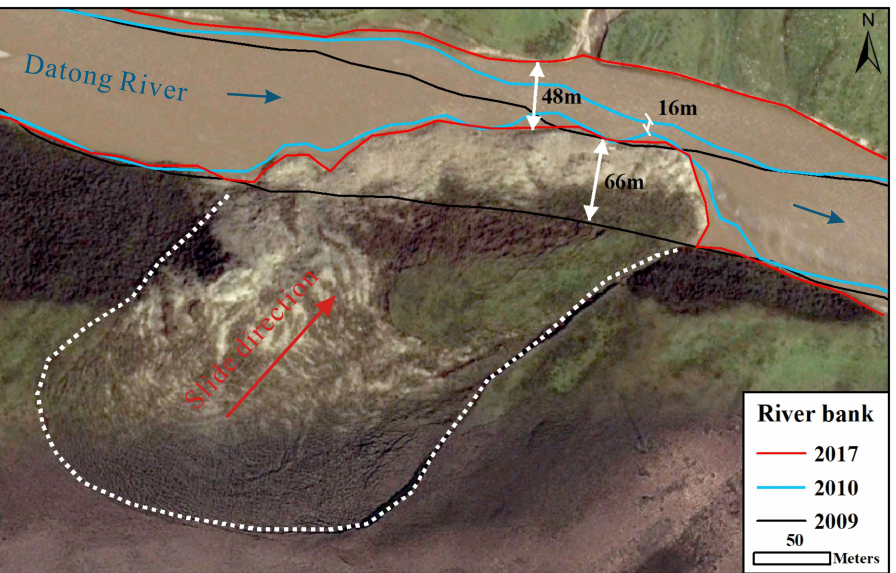
Figure 4. River bank changes of Datong River beneath the twin landslides in 2009, 2010, and 2017. In 2009, the thinnest section of the Datong River was about 66 m. In 2010, the southern river bank expanded northward due to the collapse of Landslide QLDT01, and the width was about 16 m. In 2017, the north bank continued to expand northward, and the thinnest section of the Datong River was 48